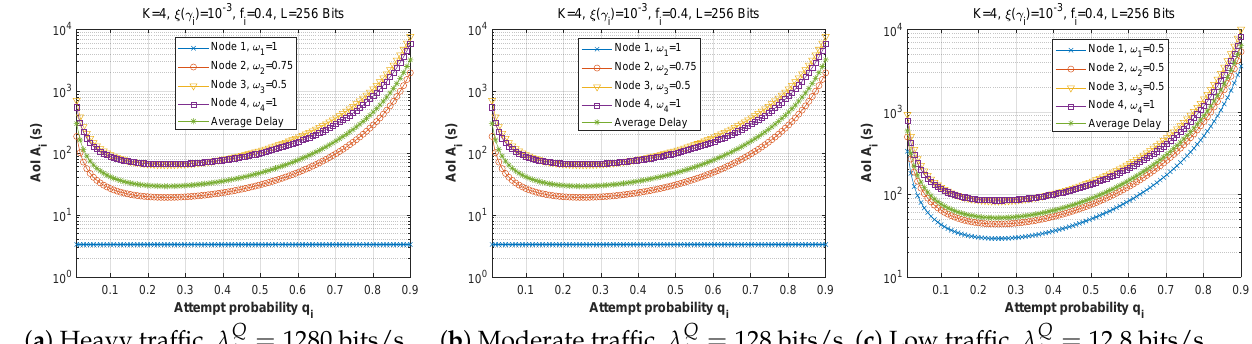
Figure 29. Setting 2: The AoI experienced at each mobile device as a function of attempt probability q i for various arrival rates λ Q . i